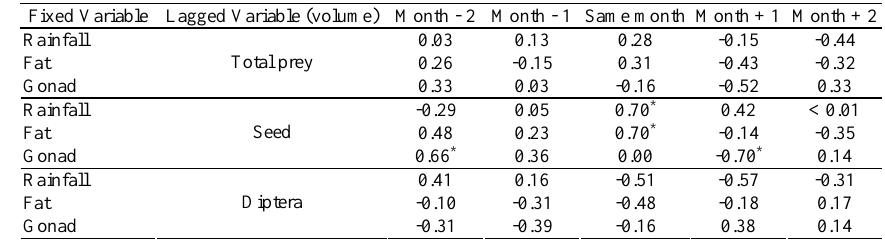
Table 3. R -values of lagged correlations. Monthly mean volumes of all prey, seeds and Diptera larvae were lagged and compared against mean monthly values of rainfall and fat and gonad weights. Comparisons were performed by lagging one or two months backward and forward, and without lagging. * P < 0.05 without adjusting nominal P -values for multiple testing. No correlation was significant after the